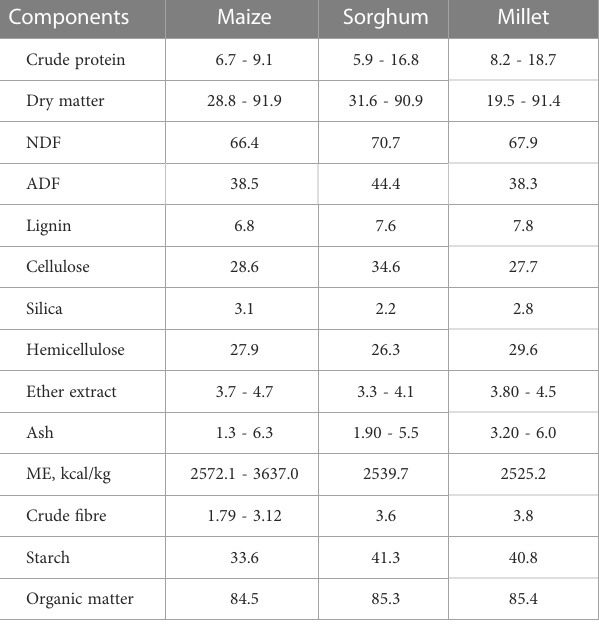
TABLE 4 Chemical composition of maize, sorghum, and millet (%, dry matter).